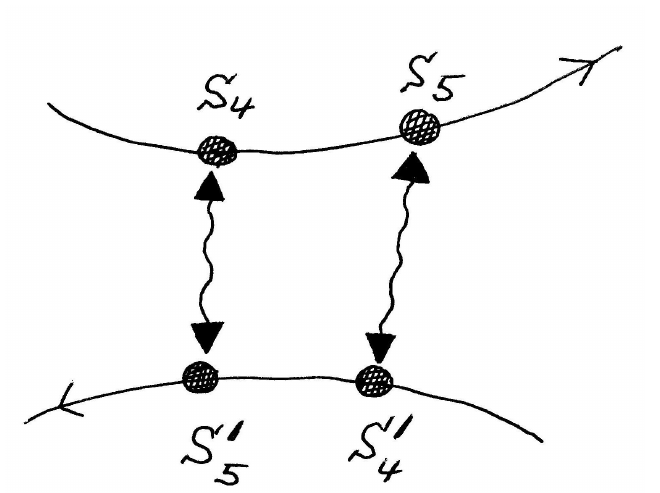
Figure 3. The Ising spins at sites 4 and 5 of two chains, with spins labelled by s k and s (cid:48) interact by exchanging spins s 4 and s (cid:48) exchanged with those of a pair of leftmovers by this momentum-conserving interaction, cf. Section3.1.